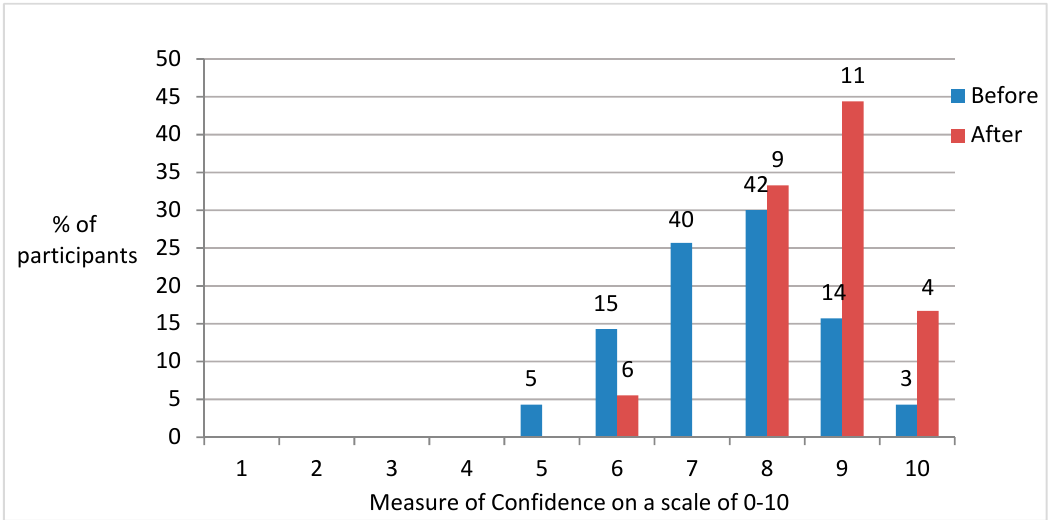
Figure 2. Changes in perceived confidence levels (where 0 = no confidence and 10 = total confidence) with respect to clinical skills in restorative dentistry before and after the programme.